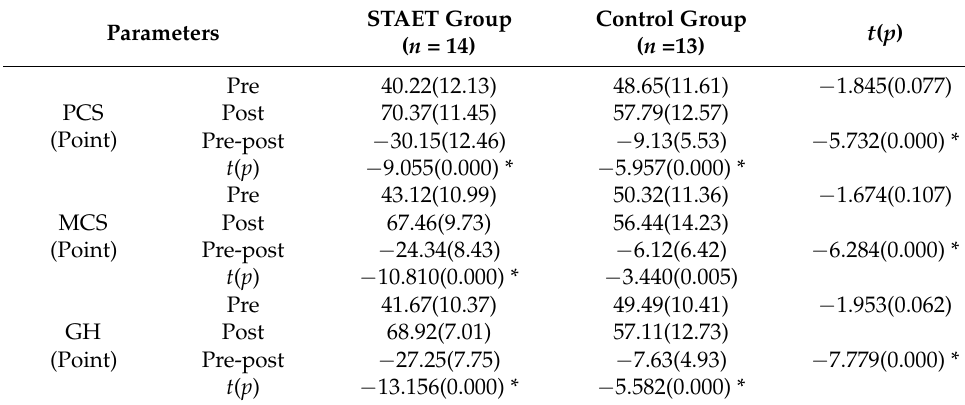
Table 7. Comparison of quality of life (N =